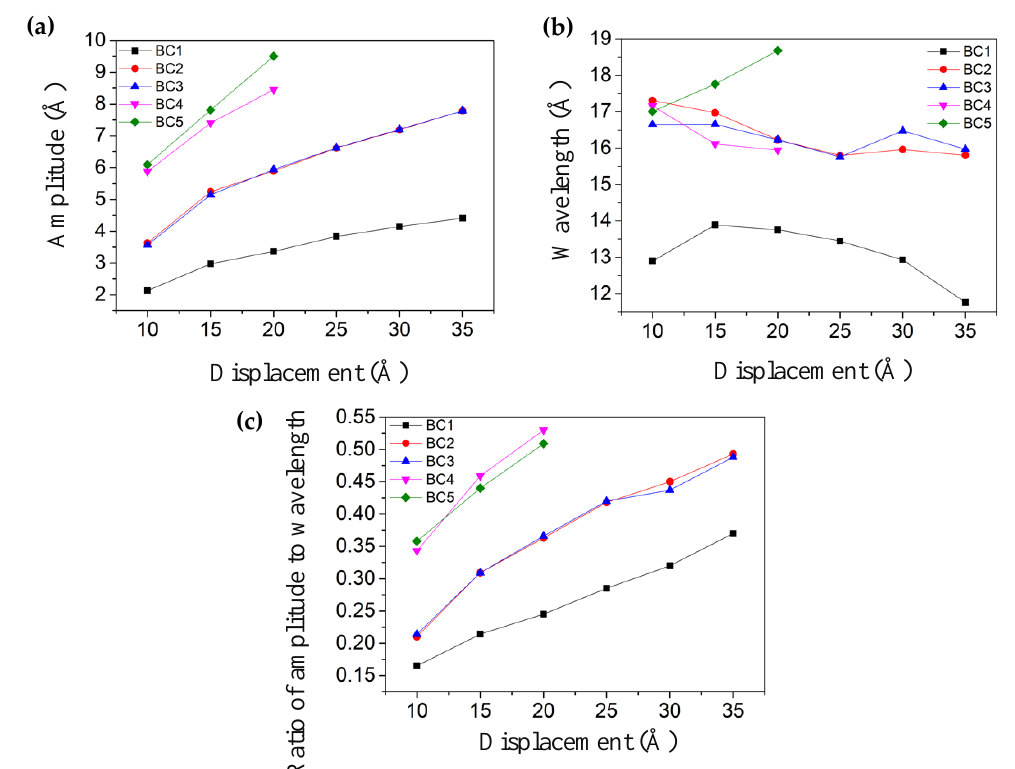
Figure 6. The relationship between the applied shear displacement and the wrinkling parameters: ( a ) Amplitude, ( b ) Wavelength, ( c ) Ratio of amplitude to wavelength, under five boundary conditions (BC1, BC2, BC3, BC4, and BC5).